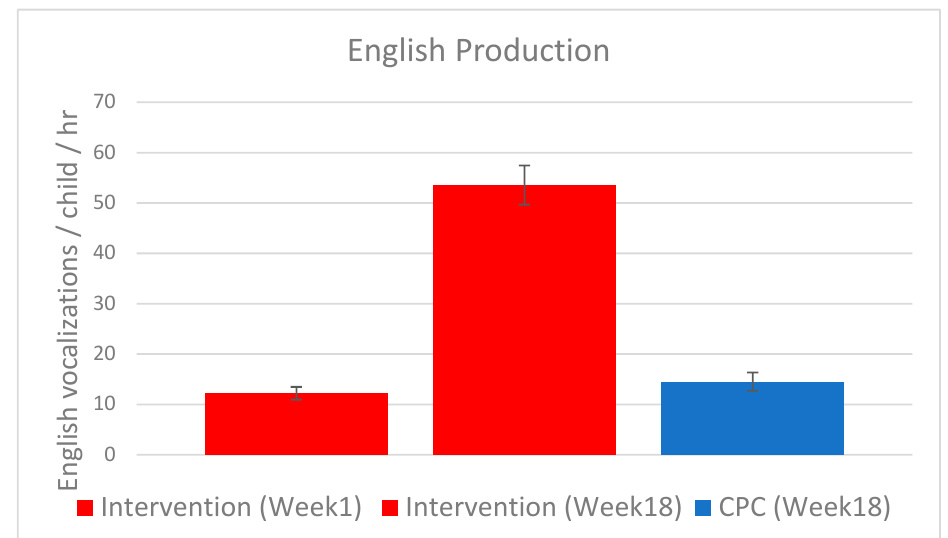
Figure 2. Mean number of English vocalizations per child per hour for Intervention group (red; n = 267) at the Week 1 and Week 18 measurement points, and for the CPC group (blue; n = 108) at the Week 18 measurement point. Error bars represent standard error.